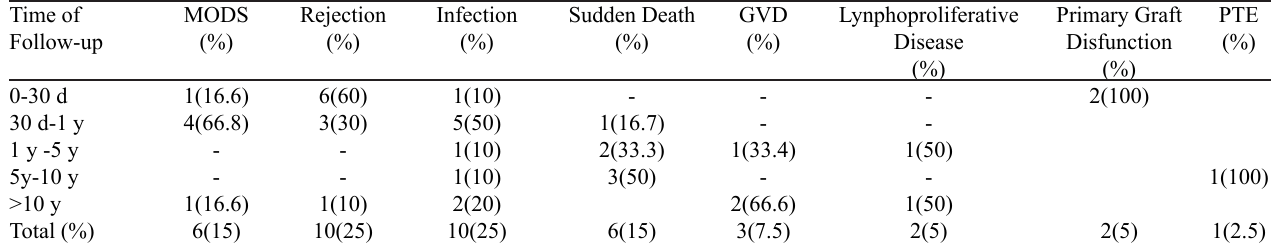
Table 2. Causes of death according to the time of HTx follow-up. Time